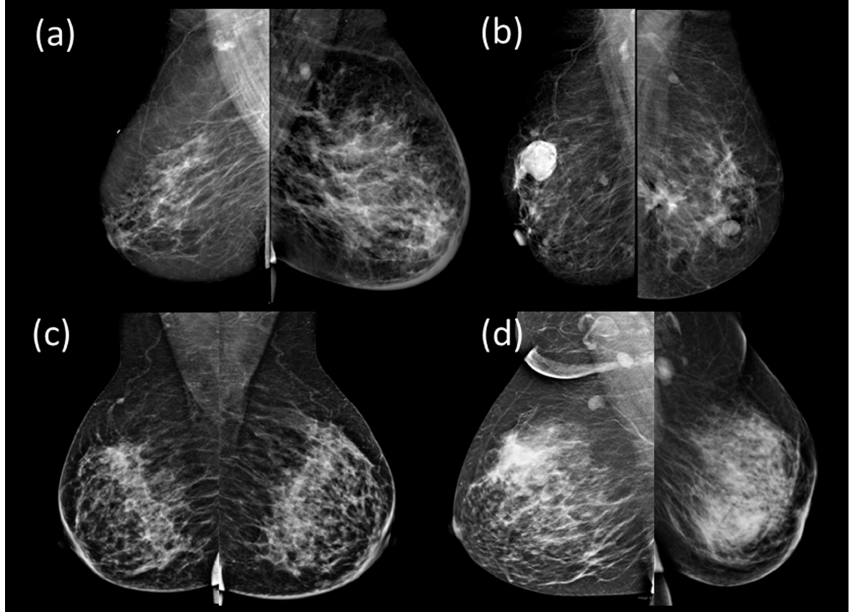
Figure 1. MLO views of four digital bilateral mammography images showing ( a ) IBC (present at the left breast), ( b ) non-IBC cancer, ( c ) benign, and ( d ) chronic granulomatous mastitis (CGM) (present at the left breast).